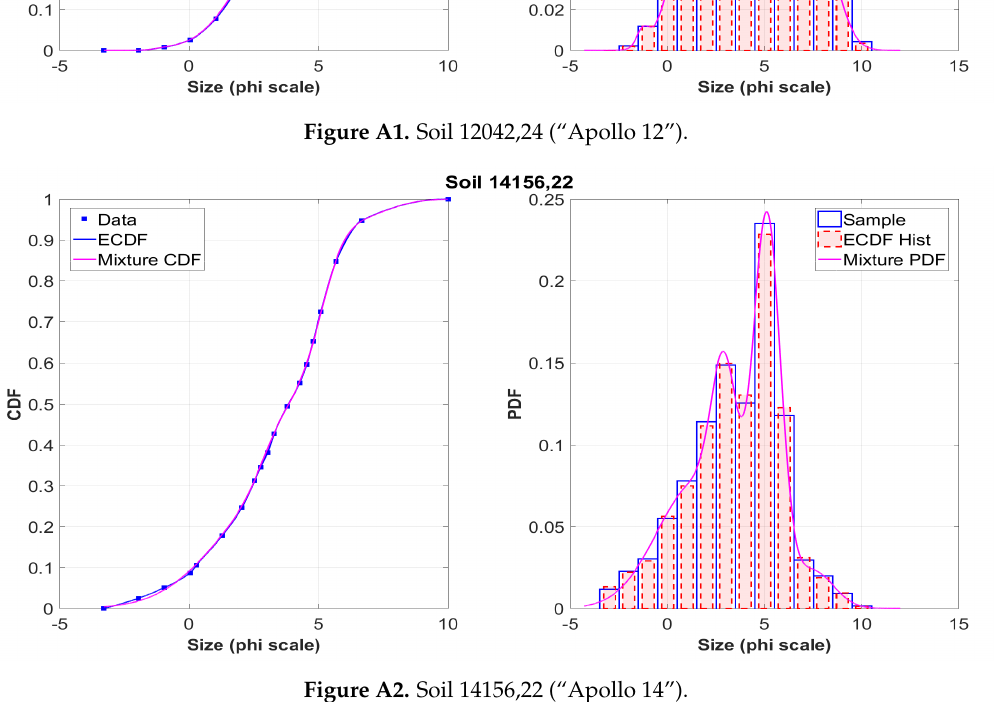
Figure A2. Soil 14156,22 (“Apollo 14”).